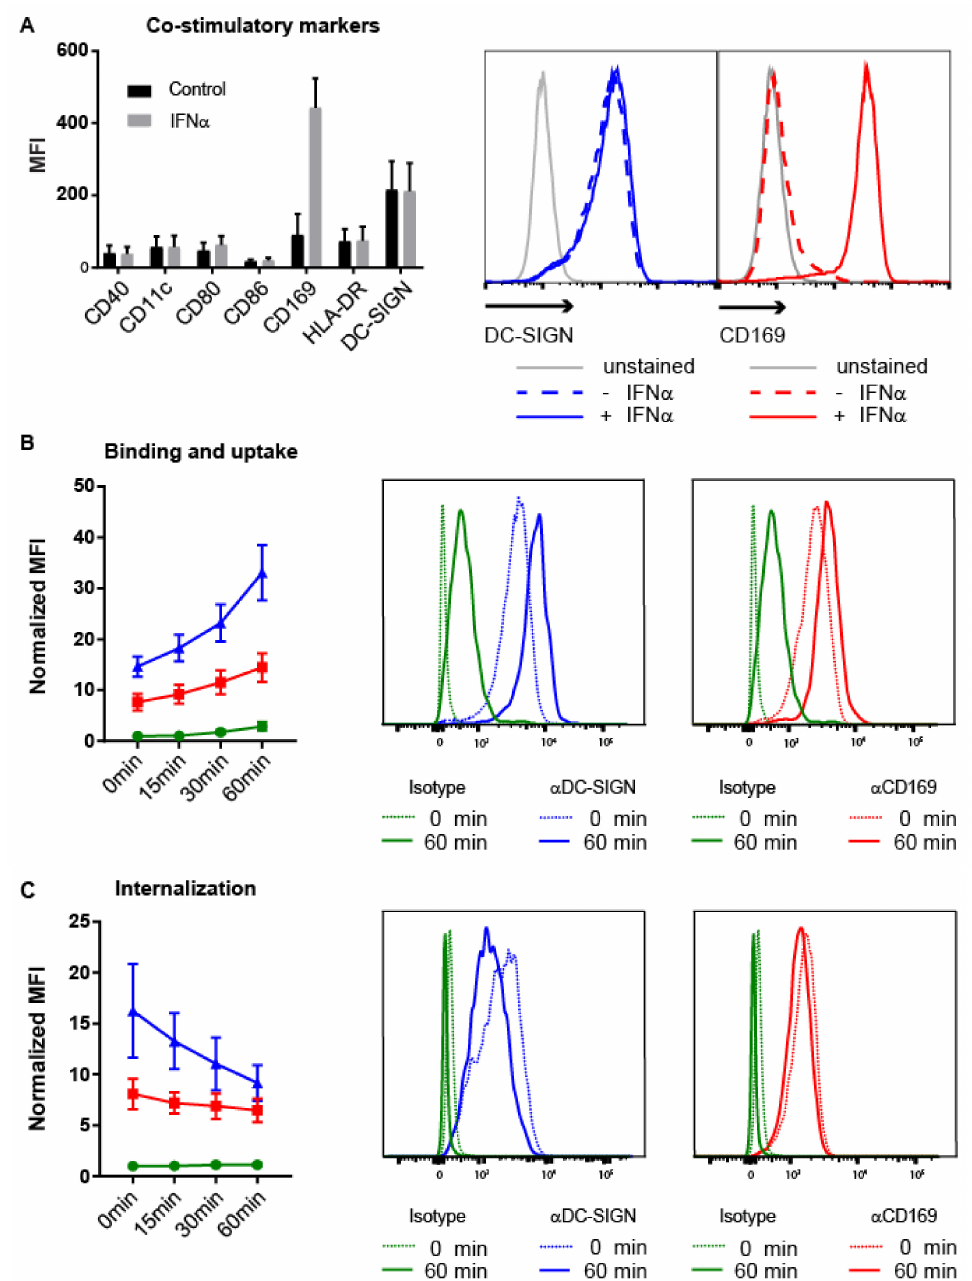
Figure 4. Expression of CD169 and DC-SIGN on human MoDCs and binding and internalization of Ab-Ag conjugates. ( A ) Expression of DC maturation markers and CD169 on unstimulated MoDCs (black) or IFN γ stimulated MoDCs (grey) ( n = 5). ( B ) Binding and uptake of specific Abs for CD169 (red), DC-SIGN (blue) and an isotype control (green). Cells were incubated with Abs for 45 min on ice, directly followed by 45 min incubation on ice with a secondary Ab. Subsequently, cells were kept on ice ( t = 0 min), or incubated at 37 ◦ C for indicated times and finally analyzed by flow cytometry ( n = 4). ( C ) Receptor internalization after incubation with specific Abs for CD169 (red), DC-SIGN (blue) and an isotype control (green). Cells were incubated with the Abs for 45 min on ice and subsequently washed to remove unbound Ab. Next, cells were kept on ice ( t = 0 min) or incubated at 37 ◦ C for indicated times. Receptors remaining on the cell surface were visualized by flow cytometry after incubation with a secondary Ab ( n = 3). ( A – C ) Representative histograms of DC-SIGN (blue, middle panel) and CD169 (red, right panel) expression are shown. ( B , C ) MFIs are normalized to isotype control at 0